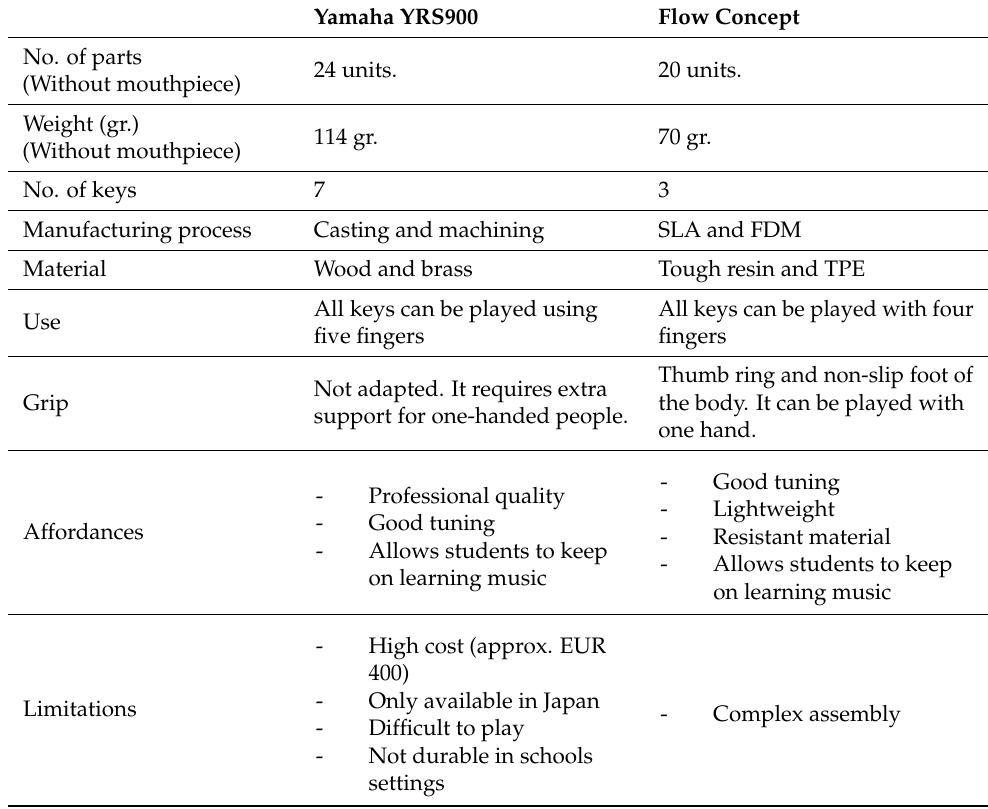
Table 2. Comparison between Flow designs proposed and the adapted Yamaha YRS900.